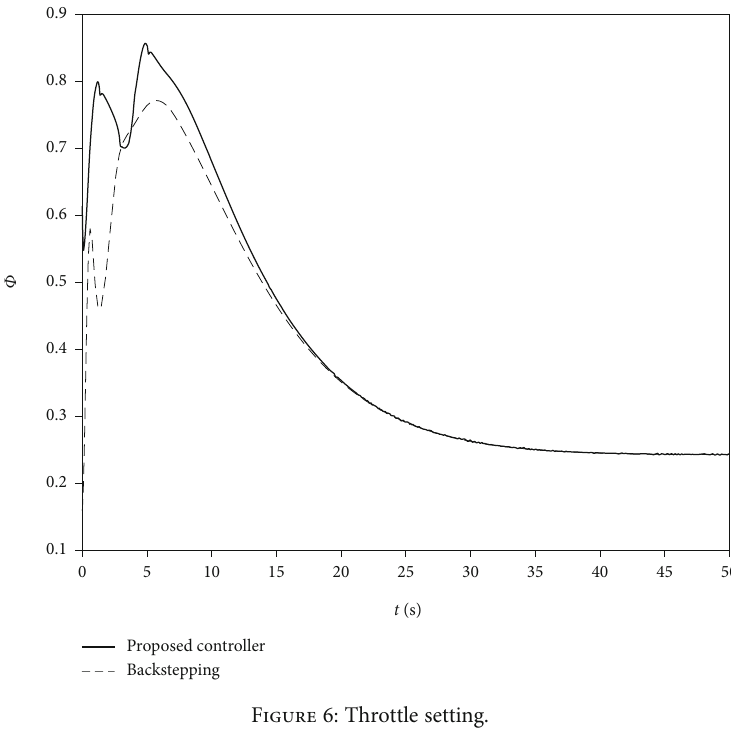
Figure 6: Throttle setting.